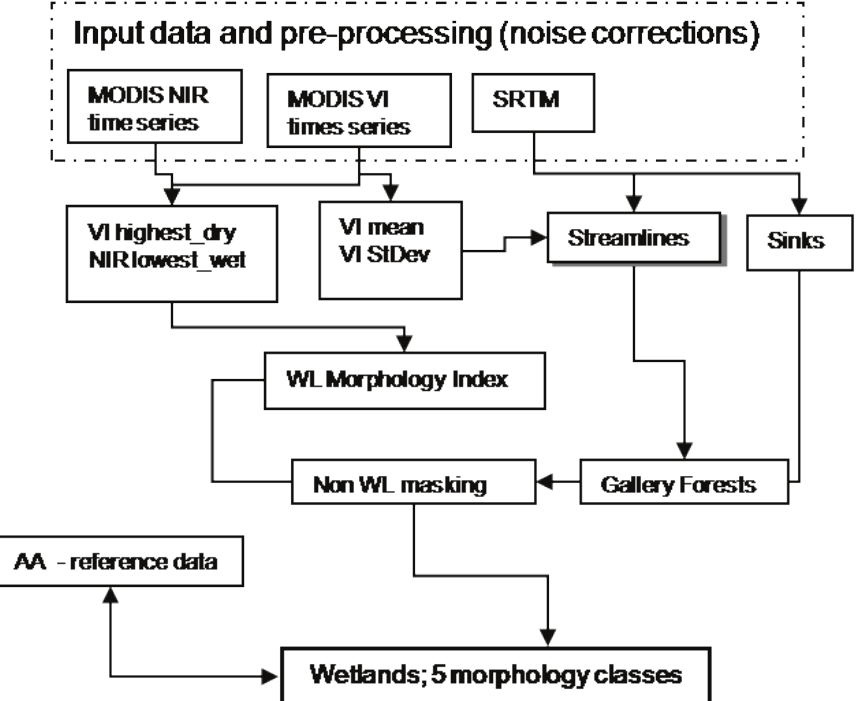
Figure 1. Wetland mapping data processing flowchart. The ‘VI-mean’ and ‘VI StDev’ refer to the temporal mean and standard deviation of VI for the whole year, respectively; Shuttle Radar Topographic Mission data: 90-meter digital elevation model (DEM) data from SRTM; AA: Accuracy assessment; ‘VI highest_dry’: highest VI metrics class in